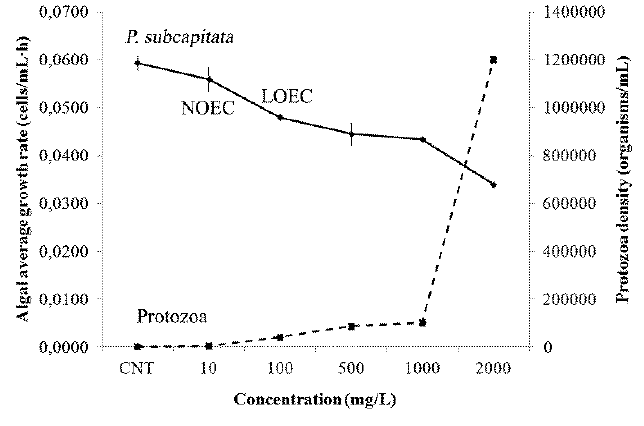
Figure 5. Algal average growth rate of P. subcapitata (cells/mL·h) and protozoa density (organisms/mL) at the different concentrations of zosteric acid and control. No observed effect concentration (NOEC) and low effect observed concentration (LOEC) on algal growth rate are also